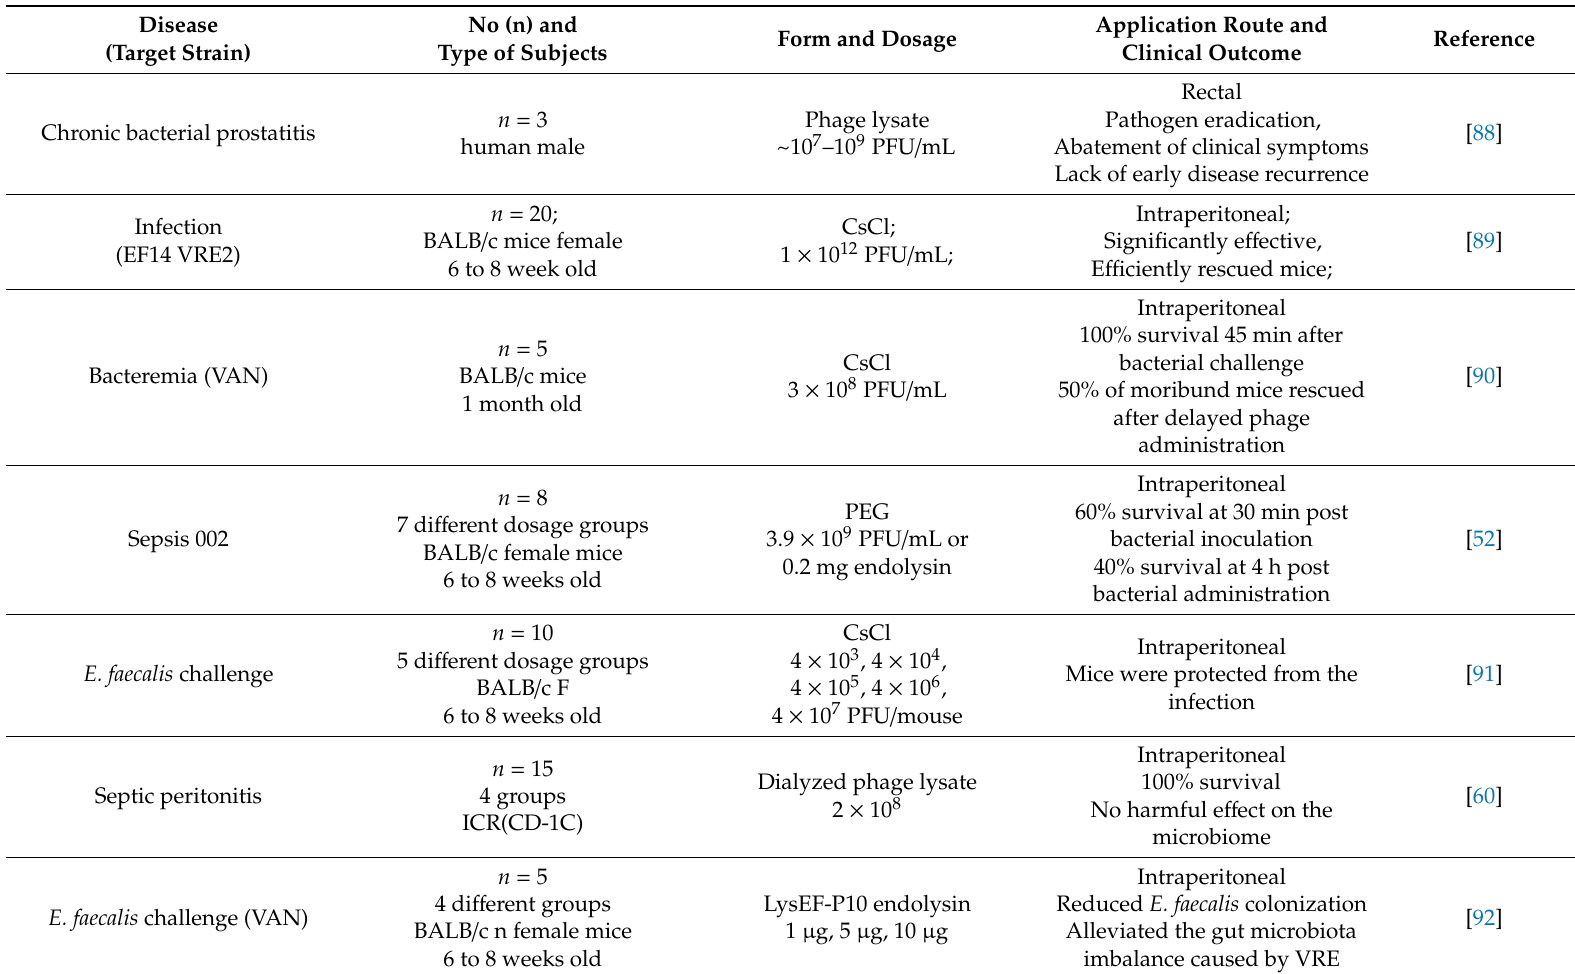
Table 1. Target infections, phage dosage, and outcomes in Enterococcus faecalis phage therapy in vivo